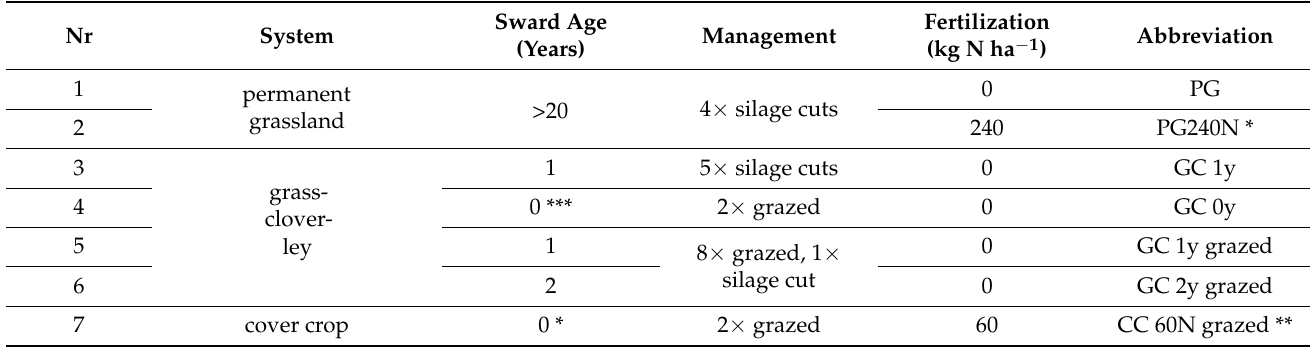
Table 1. Different pasture systems and fertilization levels evaluated in the current field